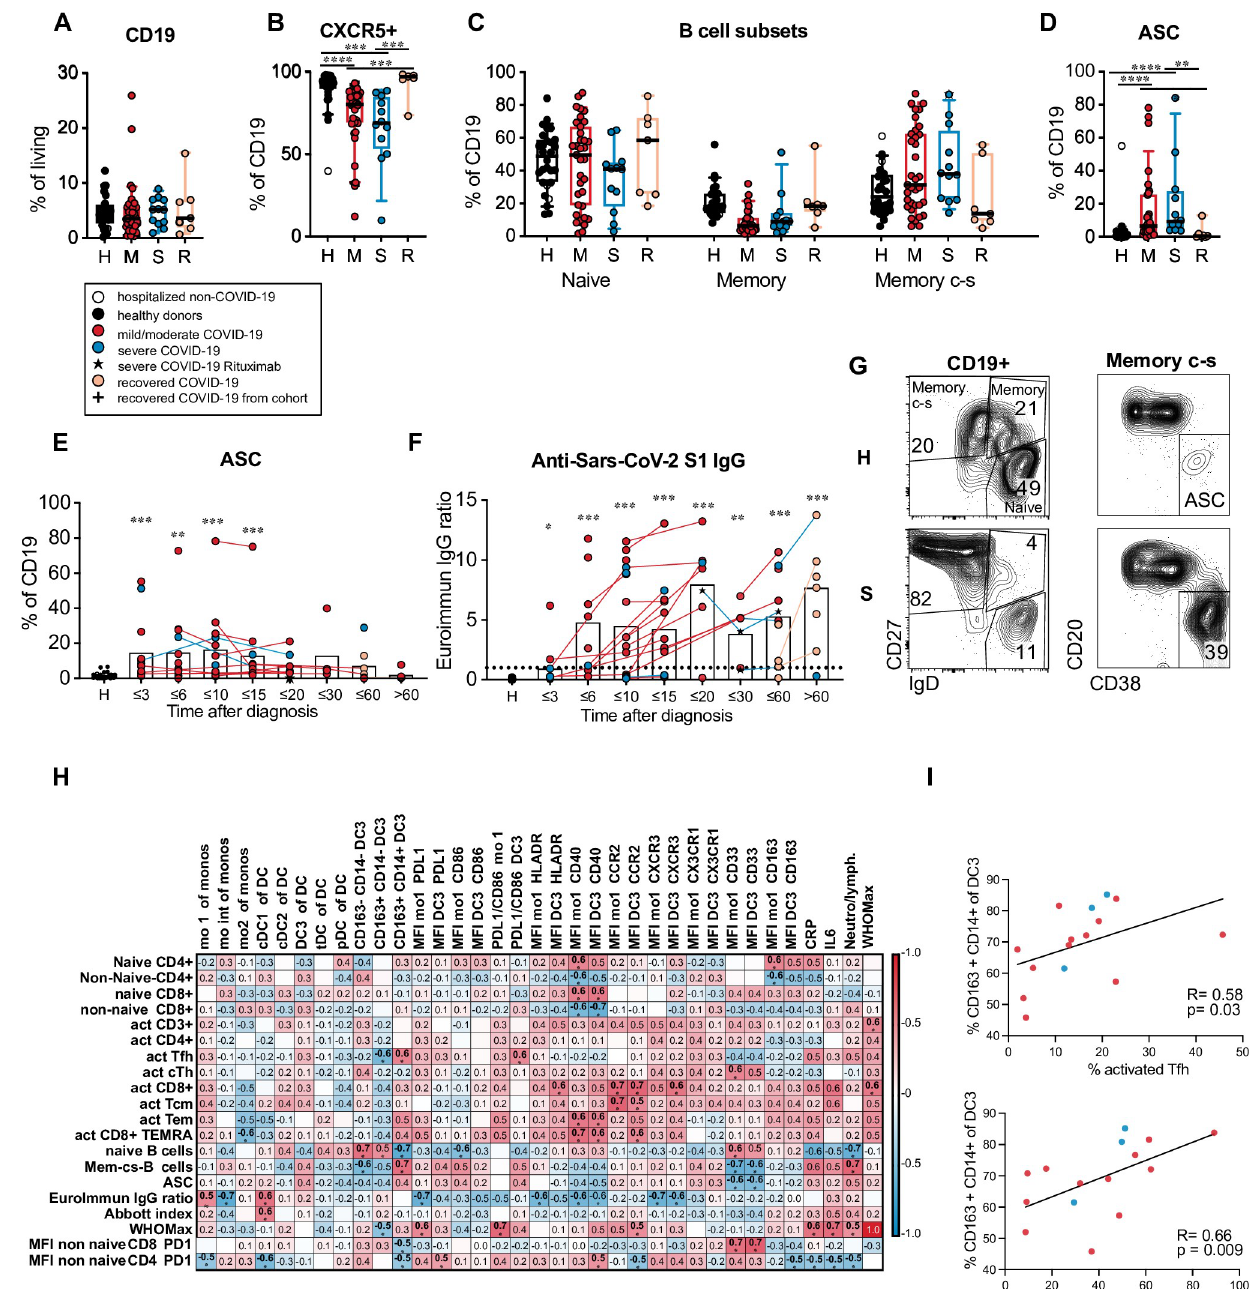
Fig 8. DC3 and monocyte phenotype correlates with Tfh and B cell activation. (A) Frequency of CD19 + B cells within living PBMC, (B) percentage of CXCR5 + cells within the CD19 + B cells, (C) percentage of na ï ve and memory B cell subsets within CD19 + cells, (D) percentage of antibody-secreting cells (ASC) within CD19 + B cells in healthy/non-COVID controls (H, black/white symbols n = 24) and acute COVID-19 patients with mild/moderate (M, red, n = 35) or severe disease (S, blue, n = 13) at the first analysis timepoint and in recovered patients (R, orange, n = 7). Patients that had received B cell- depleting therapies were excluded. Kruskal-Wallis test with Dunn’s correction. (E) Frequency of ASC within CD19 + B cells (n = 102). (F) anti-SARS-CoV-2 spike S1 IgG levels (Euroimmun IgG ratio) in plasma samples (n = 105) of patients at different time points and in controls. The dotted line indicates the cutoff value for the antibody test. (E, F) Symbols indicate individual measurements (see legend in A). Connected lines represent multiple measurements of the same donor. Columns indicate the mean. Data from each grouped time point were compared with data from the control group. Kruskal-Wallis test with Dunn’s correction, � p < 0.05, �� p > 0.01, ��� p < 0.001. (G) Gating strategy for B cell subpopulations and ASC. Representative results from a healthy donor and a COVID-19 patient with severe disease are shown. (H) Correlation analysis of innate parameters up to 10 days after diagnosis (horizontal) with adaptive parameters at day 10 to 25 after diagnosis (vertical) in the same patients (n = 9–17). Spearman’s rank correlation coefficients (-1 to 1) are indicated